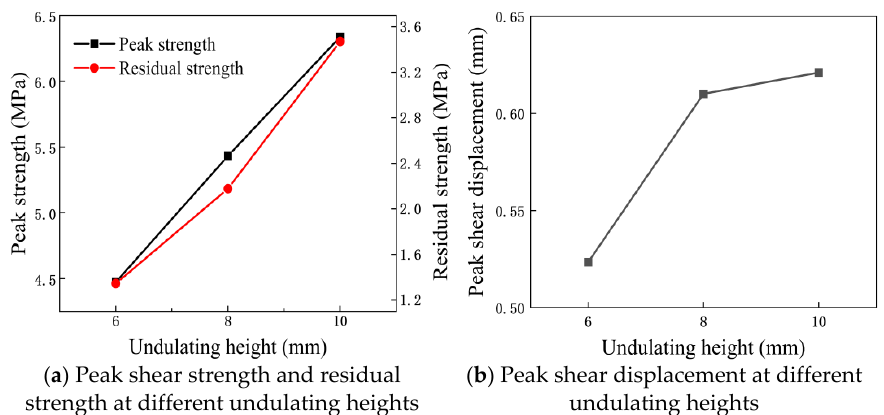
Figure 8. Shear strength curves under the influence of different undulating heights.